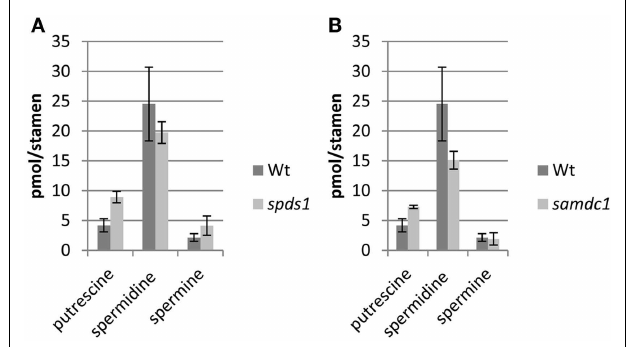
FIGURE 8 | PA levels in stamen of A. thaliana samdc1 (A) and spds1 (B) mutants compared to wild type.